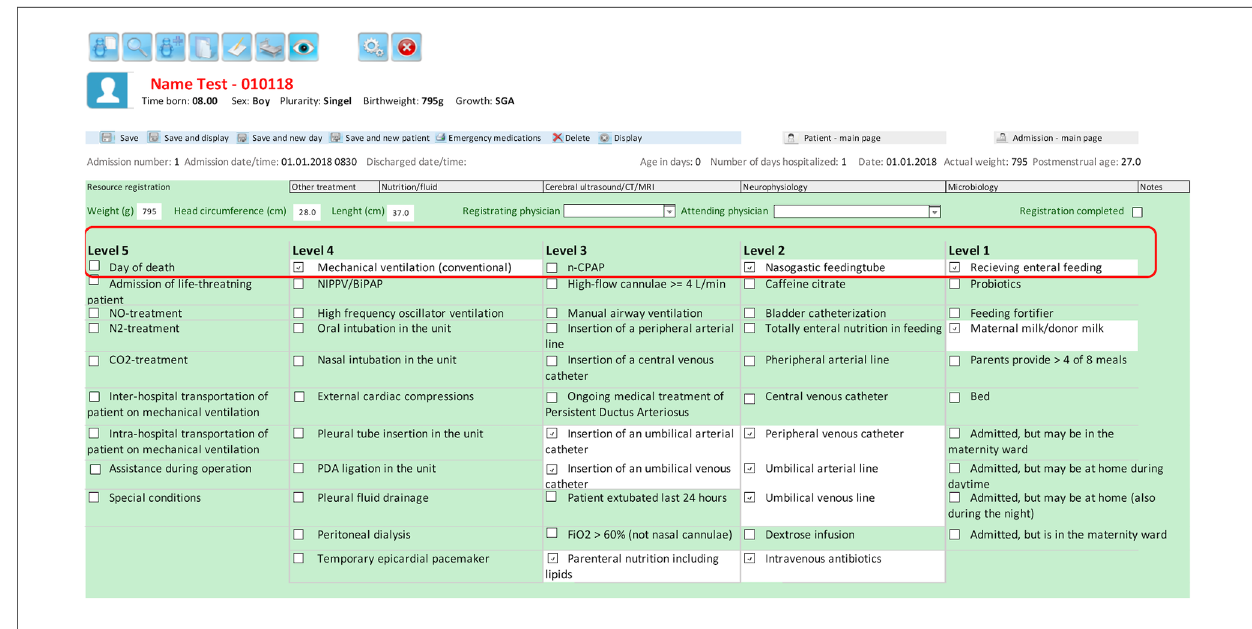
FIGURE 1 Screenshot of part of the daily resource registration form in the Norwegian neonatal network database (the patient classi fi cation system, with levels 1 – 5). This form was translated into English from